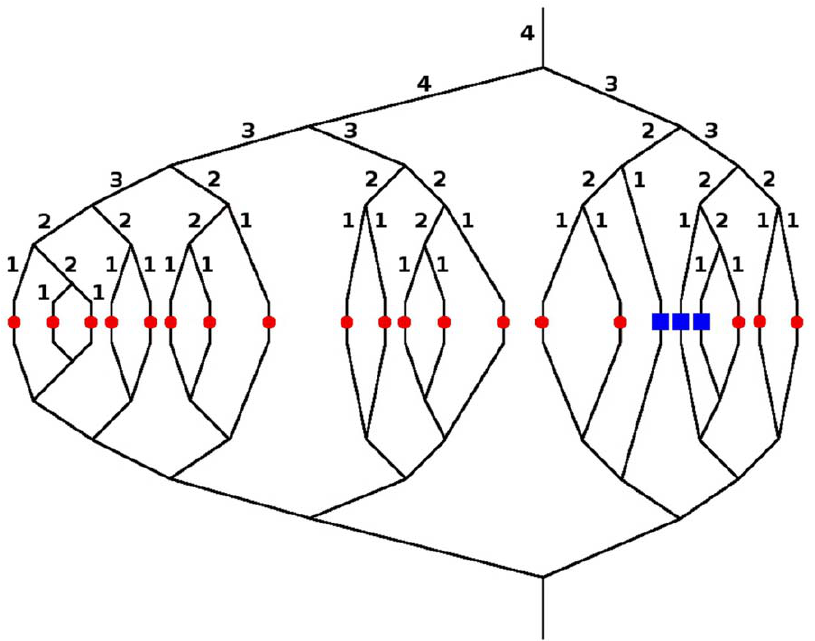
Figure 10. Visualization of the vascular graph coupled to the DCM. The black lines represent the blood vessels, which form the unstructured grid of the VGM. The red nodes and the blue rectangles symbolize the capillary bed and pulmonary tissue around an alveolus, which are simulated using the DCM. The red nodes are the healthy upscaled nodes and the blue rectangles are the tumorous ones. The blood vessels above/below the alveoli are arteries/veins of the order one to four, with a morphology according to Table 1 and Table 2 respectively. The numbers indicate the classification of the vessel segments according to the Strahler ordering system.